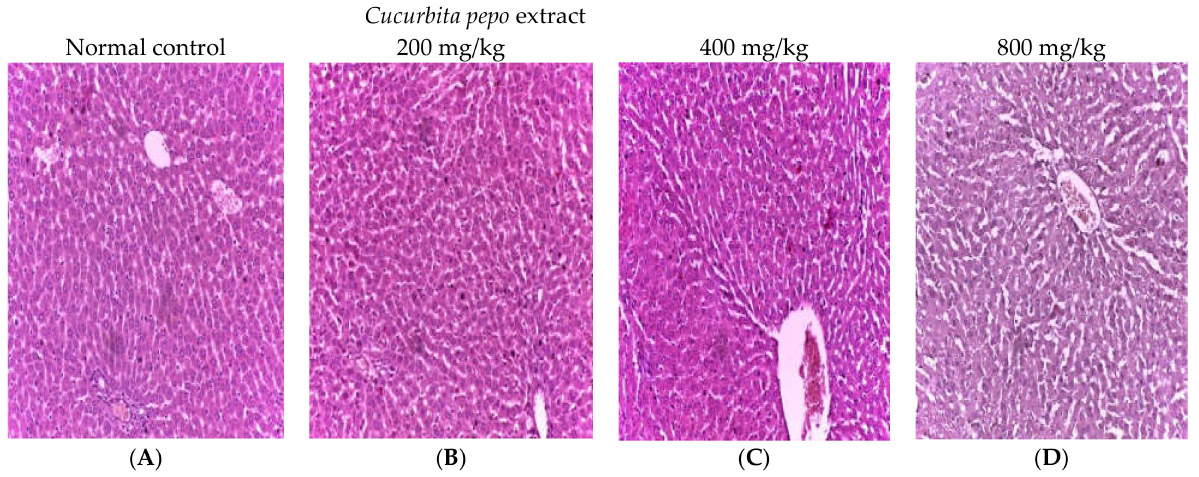
Figure 7. Micrographs of the liver sections from untreated (control) and treated albino rats with various doses of aqueous leaf extract of C. pepo. Haematoxylin and eosin staining (H and E), magnifi- cation (400 × g ). ( A ), control; ( B ), Albino rats treated with 200 mg/kg aqueous leaf extract of C. pepo ; ( C ), Albino rats treated with 400 mg/kg aqueous leaf extract of C. pepo ; and ( D ), Albino rats treated with 800 mg/kg aqueous leaf extract of C. pepo .